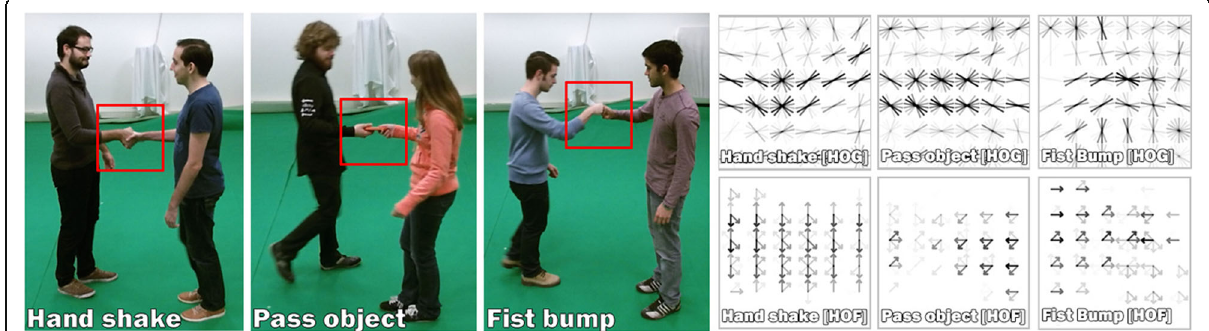
Fig. 1 Interactions that differ slightly in pose (HOG) or movement (HOF). The red bounding boxes show the areas of the right hands, with part descriptors shown on the